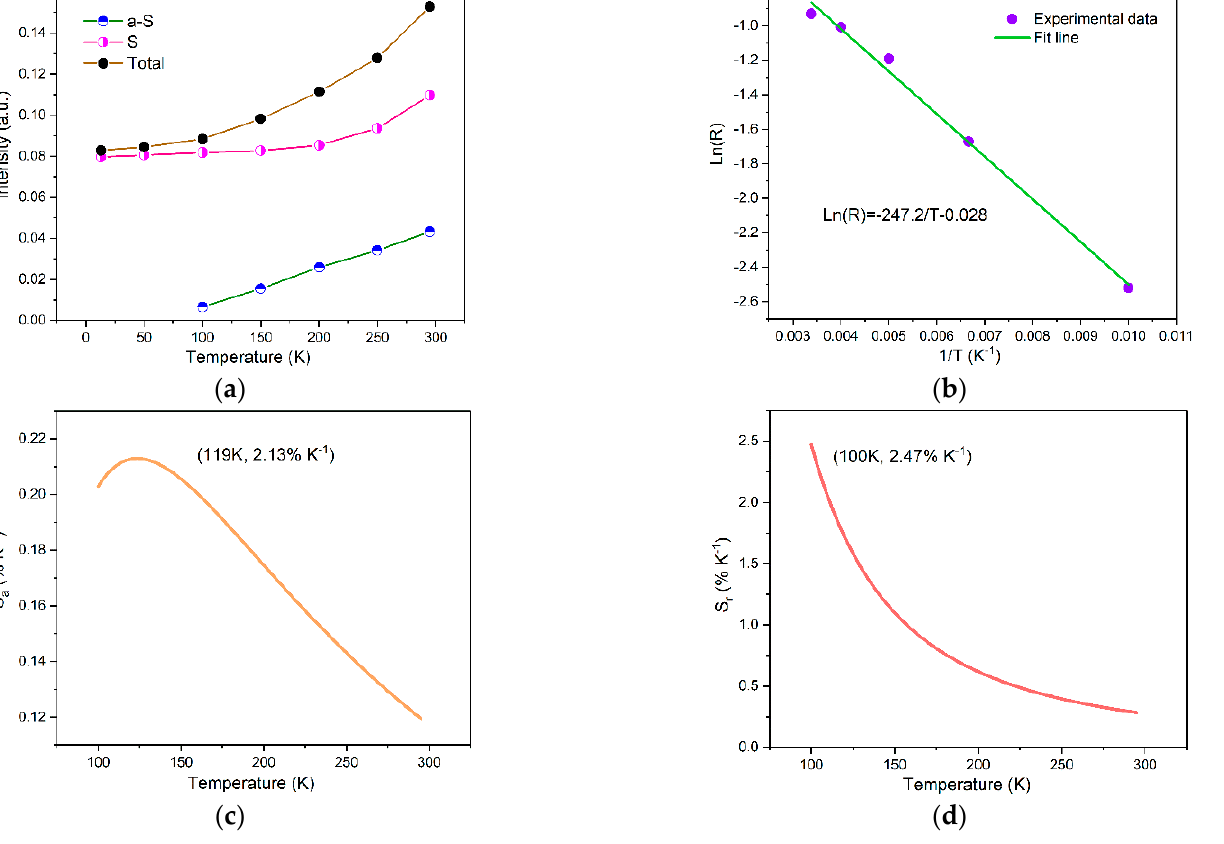
Figure 8. ( a ) Integral emission intensities of anti-Stokes sidebands (blue), Stokes sidebands (red), and total Mn 4+ emission (black) as a relation with temperature from 13 to 295 K; ( b ) emission intensity ratio of anti-Stokes vs. Stokes sidebands (R) in a log relation with 1/T; ( c ) calculated absolute sensitivity; ( d ) calculated relative